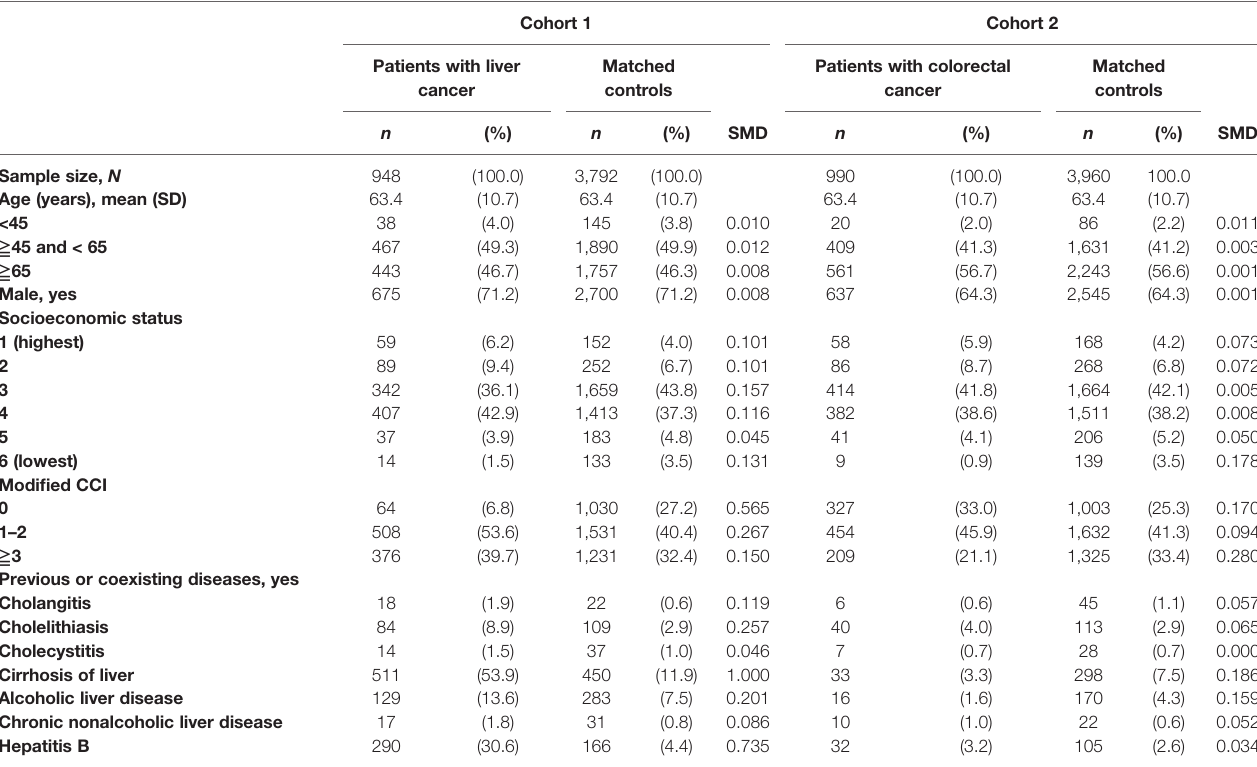
TABLE 1 | Characteristics of patients with liver and colorectal cancer and age- and sex-matched controls among patients with T2DM receiving second-line therapy.